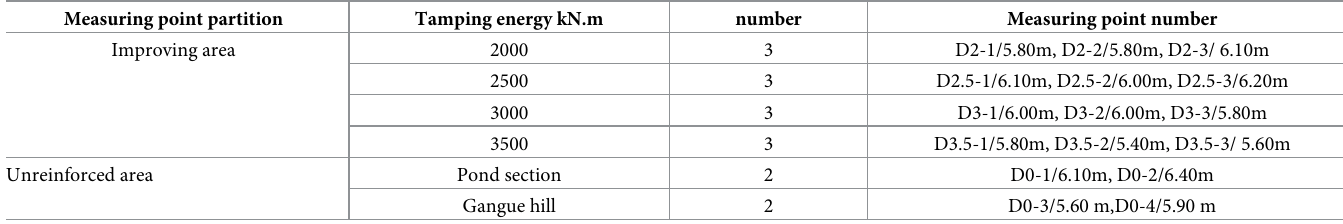
Table 2. Measuring point layout for heavy dynamic penetration test. Measuring point